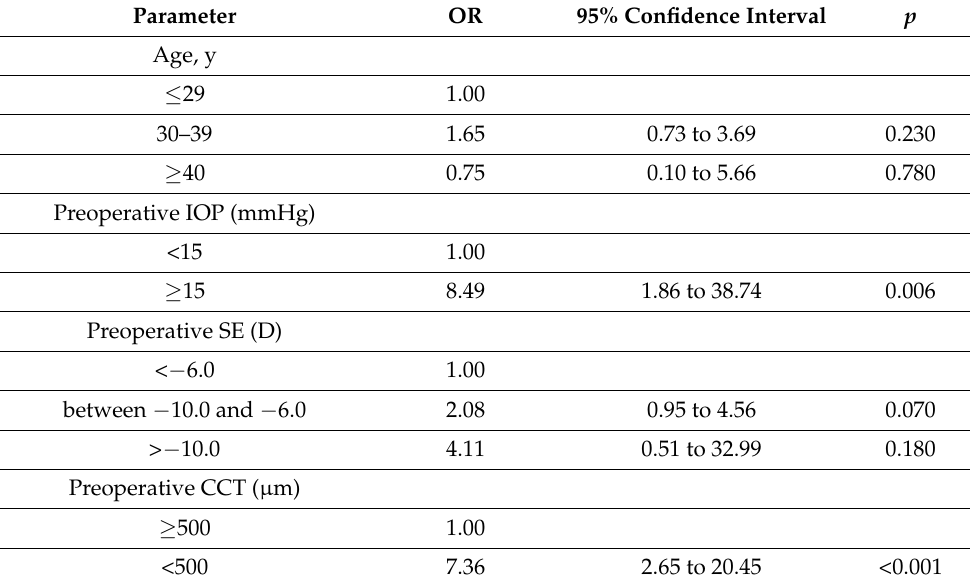
Table 7. Multivariate logistic regression analysis to assess the predictor variables of postoperative corneal